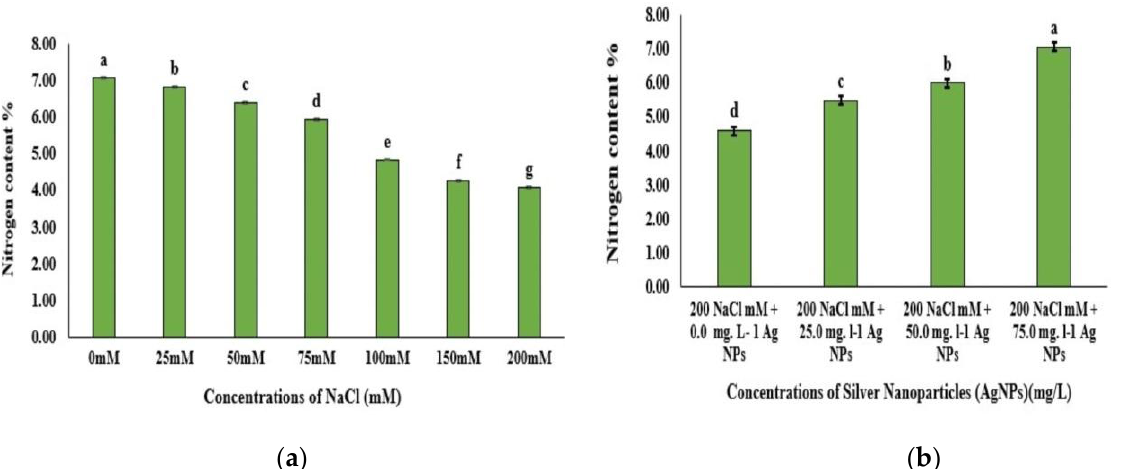
Figure 4. Nitrogen content (%) of Q6 quinoa plantlets. ( a ) Effect of different NaCl levels on N content (%) of Q6 quinoa plantlets; ( b ) effect of adding different levels of Ag NPs on protein content of Q6 quinoa plantlets grown under the highest NaCl level. Data are the means ± SE of three replicates. Different letters within the columns indicate the means that have a significant difference at the p ≤ 0.05 probability levels. Vertical bars represent the standard error at the p ≤ 0.05 probability